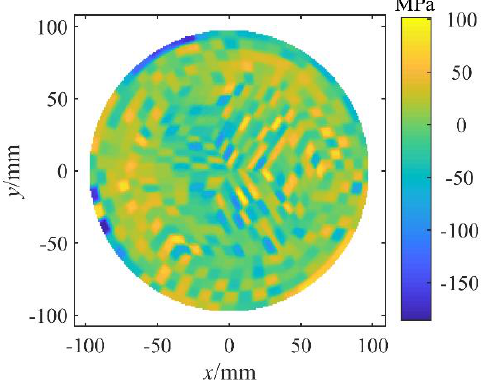
Figure 11. Residual stress distribution when the number of subareas was 525.